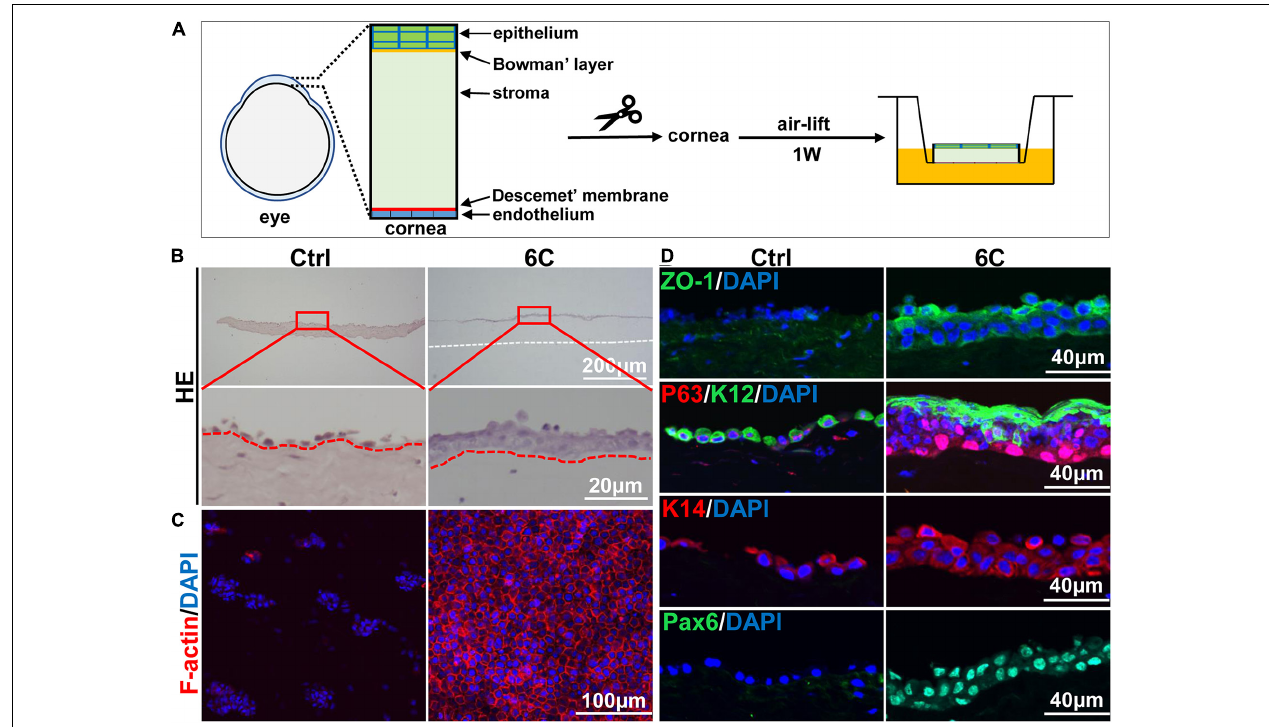
FIGURE 6 | The effect of 6C on mouse cornea ex vivo culture. (A) Schematic diagram of air-exposed culture of mouse cornea. (B) HE staining results of mouse cornea after air exposure culture. The epithelium in the 6C treatment group was relatively intact, while the control group had severe shedding (the white dotted line represents the edge of the corneal stroma and the red dotted line represents the boundary between the epithelial layer and the stromal layer). (C) Wholemount immunostaining of F-actin (red). Nuclei were stained with DAPI (blue). (D) Immunofluorescence staining of ZO-1 (green), P63 (red), K12 (green), K14 (red) and Pax6 (green). Nuclei were stained with DAPI